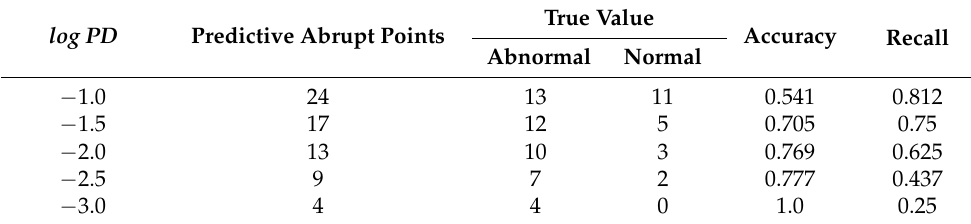
Table 3. Performance Comparison of Different Thresholds. True Value log PD Predictive Abrupt Points Accuracy Recall Abnormal Normal − 1.0 24 13 11 0.541 0.812 − 1.5 17 12 5 0.705 0.75 − 2.0 0.769 0.625 − 2.5 0.437 − 3.0 0 1.0